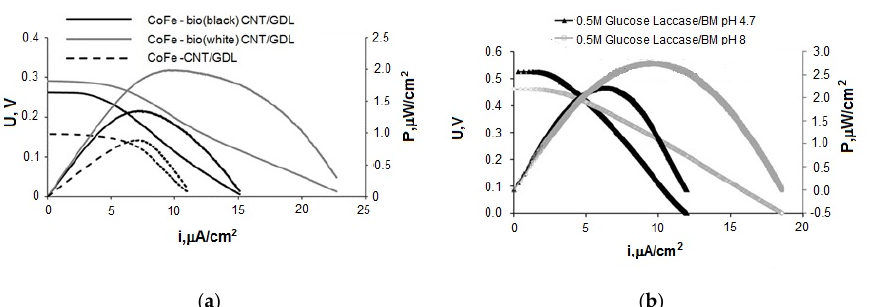
Figure 7. Current–voltage potentiodynamic curves and dependences of power density on current density, ( a ) BFC bioanode—CoFe cathode, ( b ) BFC bioanode—biocathode (laccase). density, ( a ) BFC bioanode—CoFe cathode, ( b ) BFC bioanode—biocathode